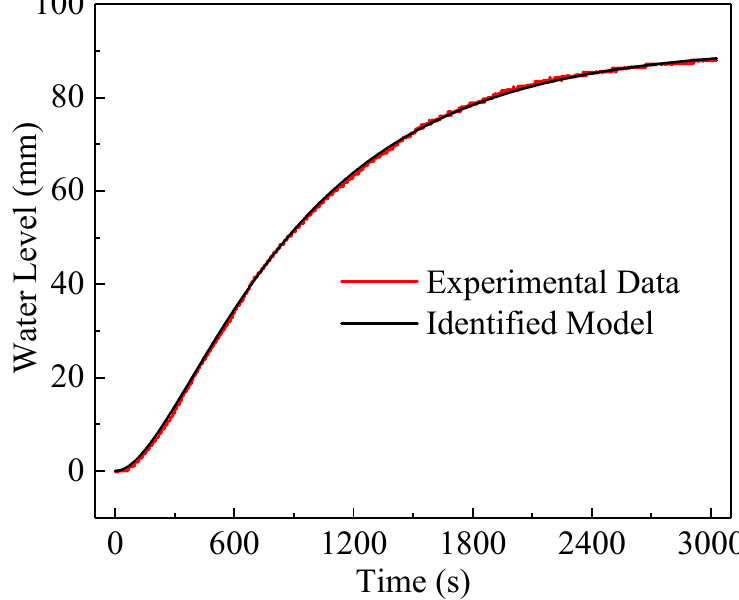
Figure 8. The fitting of experimental data with the identified model.